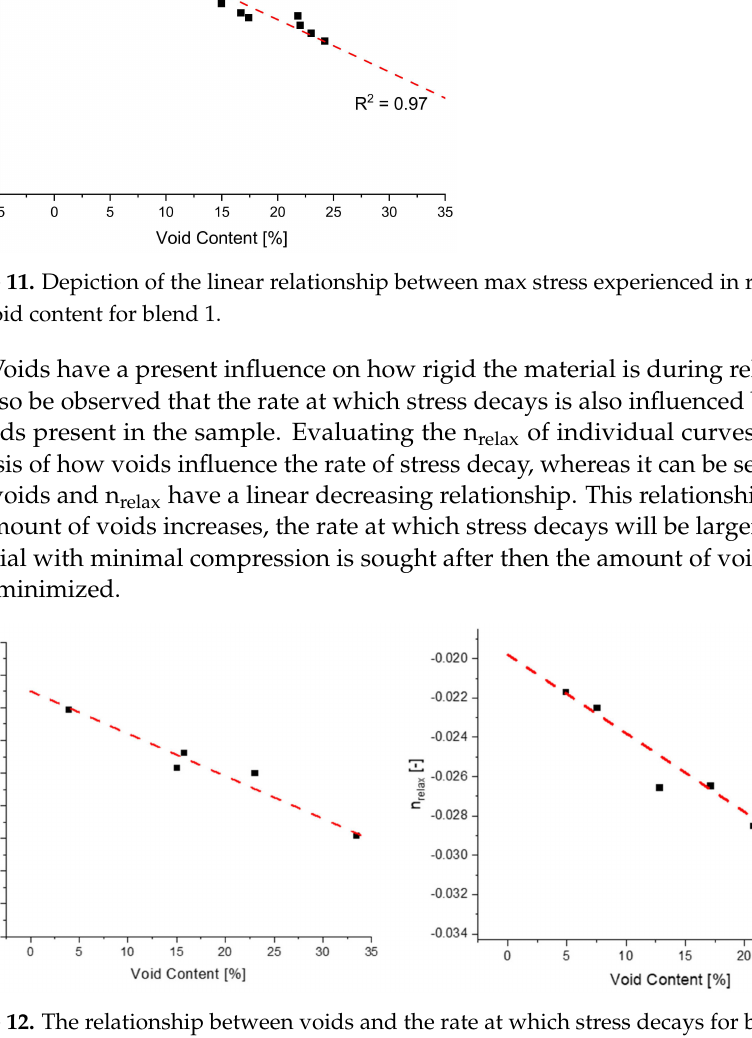
Figure 12. The relationship between voids and the rate at which stress decays for blend 9 ( left ) and 10 ( right ), characterized by n relax